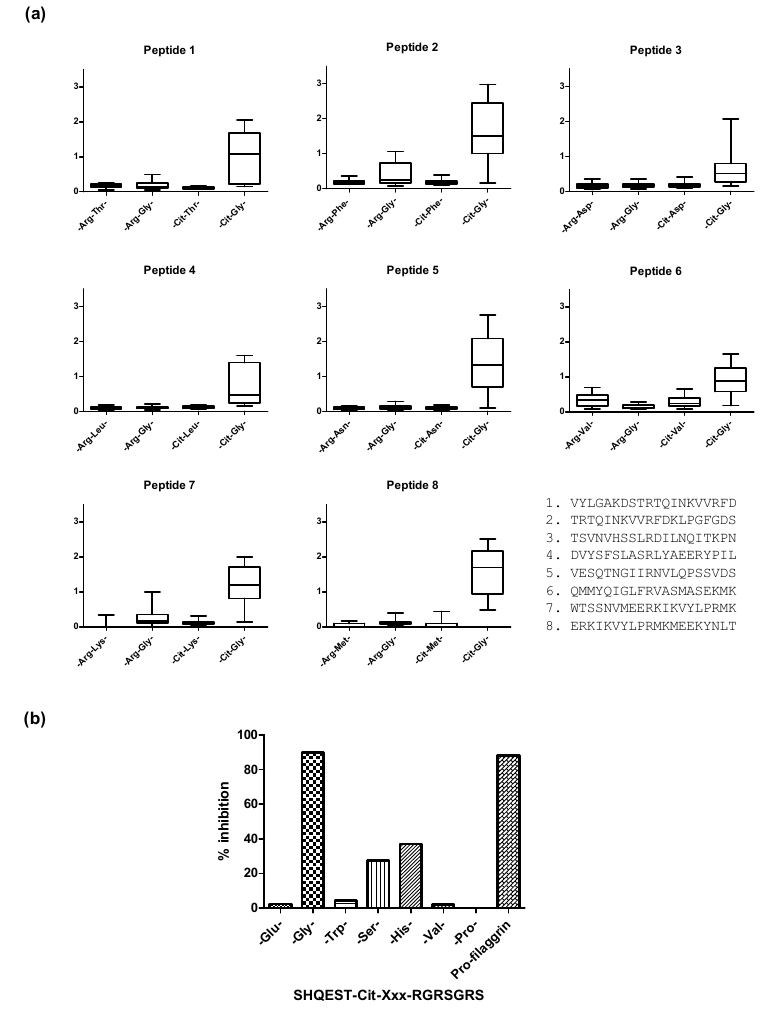
Figure 2. Anti ‐ citrullinated protein antibody reactivity to substituted citrullinated peptides. ( a ) ACPA reactivity to substituted 20 ‐ mer ovalbumin peptides. Original peptides containing Arg in a central position were used as templates. In the remaining peptides, the Arg ‐ Xxx motif was substituted with Arg ‐ Gly, Cit ‐ Xxx and Cit ‐ Gly; ( b ) ACPA reactivity to substituted pro ‐ filaggrin peptides. The peptide SHQEST ‐ Cit ‐ GRSRGRS was used as template. In the position C ‐ terminal to Cit, various amino acid residues were introduced (Glu, Gly, Trp, Ser, His, Val, Pro). The 22 ‐ mer pro ‐ filaggrin peptide (HQSHQEST ‐ Cit ‐ GRSRGRSGRSGS) was used as control.